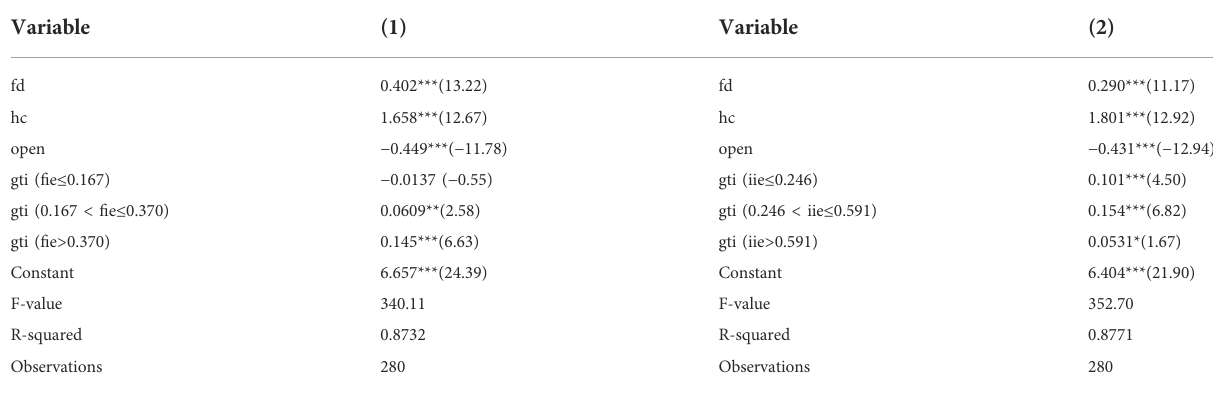
TABLE 8 Robustness test results.